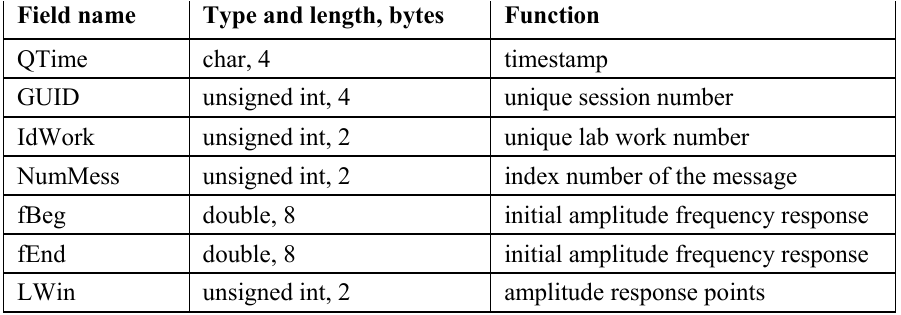
Table 1. Packet from client to server.